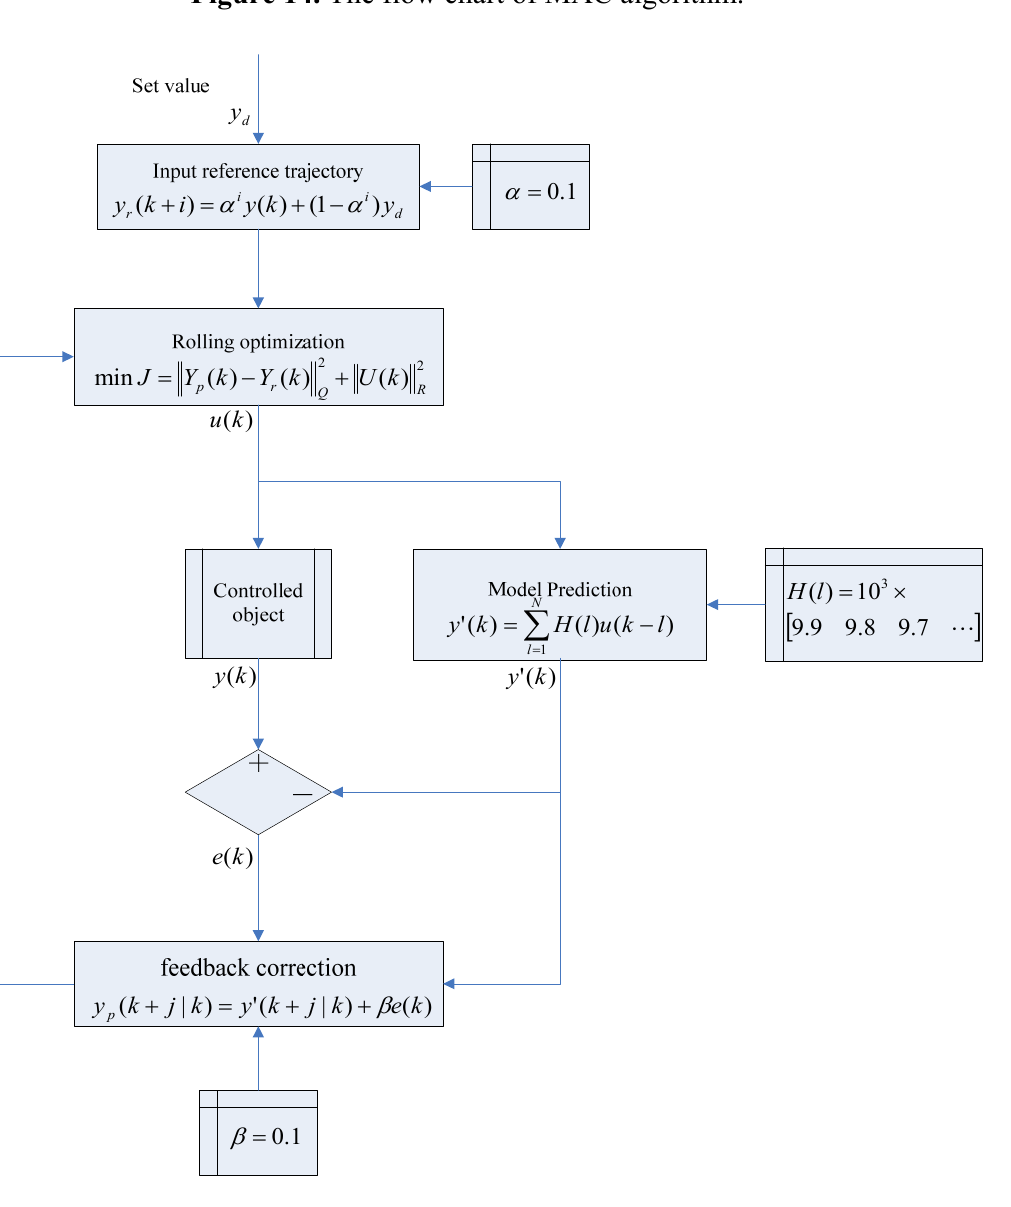
Figure 14. The flow chart of MAC